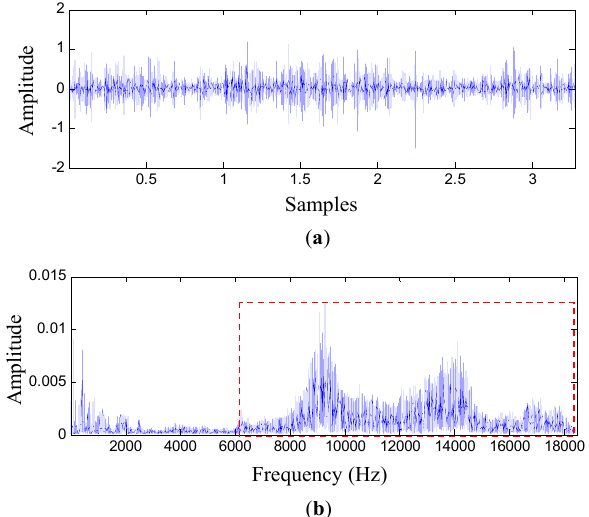
Figure 3. A vibration measurement collected from the vertical direction of the casing of the right bearing at measurement number 50: ( a ) its temporal signal and ( b ) its corresponding frequency spectrum.